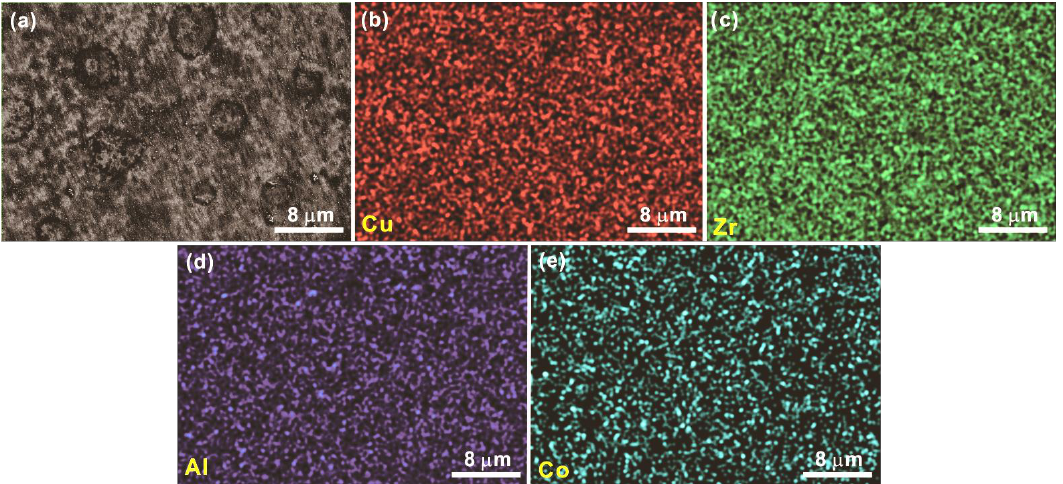
Figure 6. ( a ) Amplificatory SEM images of the as-annealed (Cu 0.5 Zr 0.5 ) 84 Al 10 Co 6 samples at a heating rate of 40 K/min at 793 K, and the EDX results for the elements ( b ) Cu, ( c ) Zr, ( d ) Al, and ( e ) Co in the present samples.